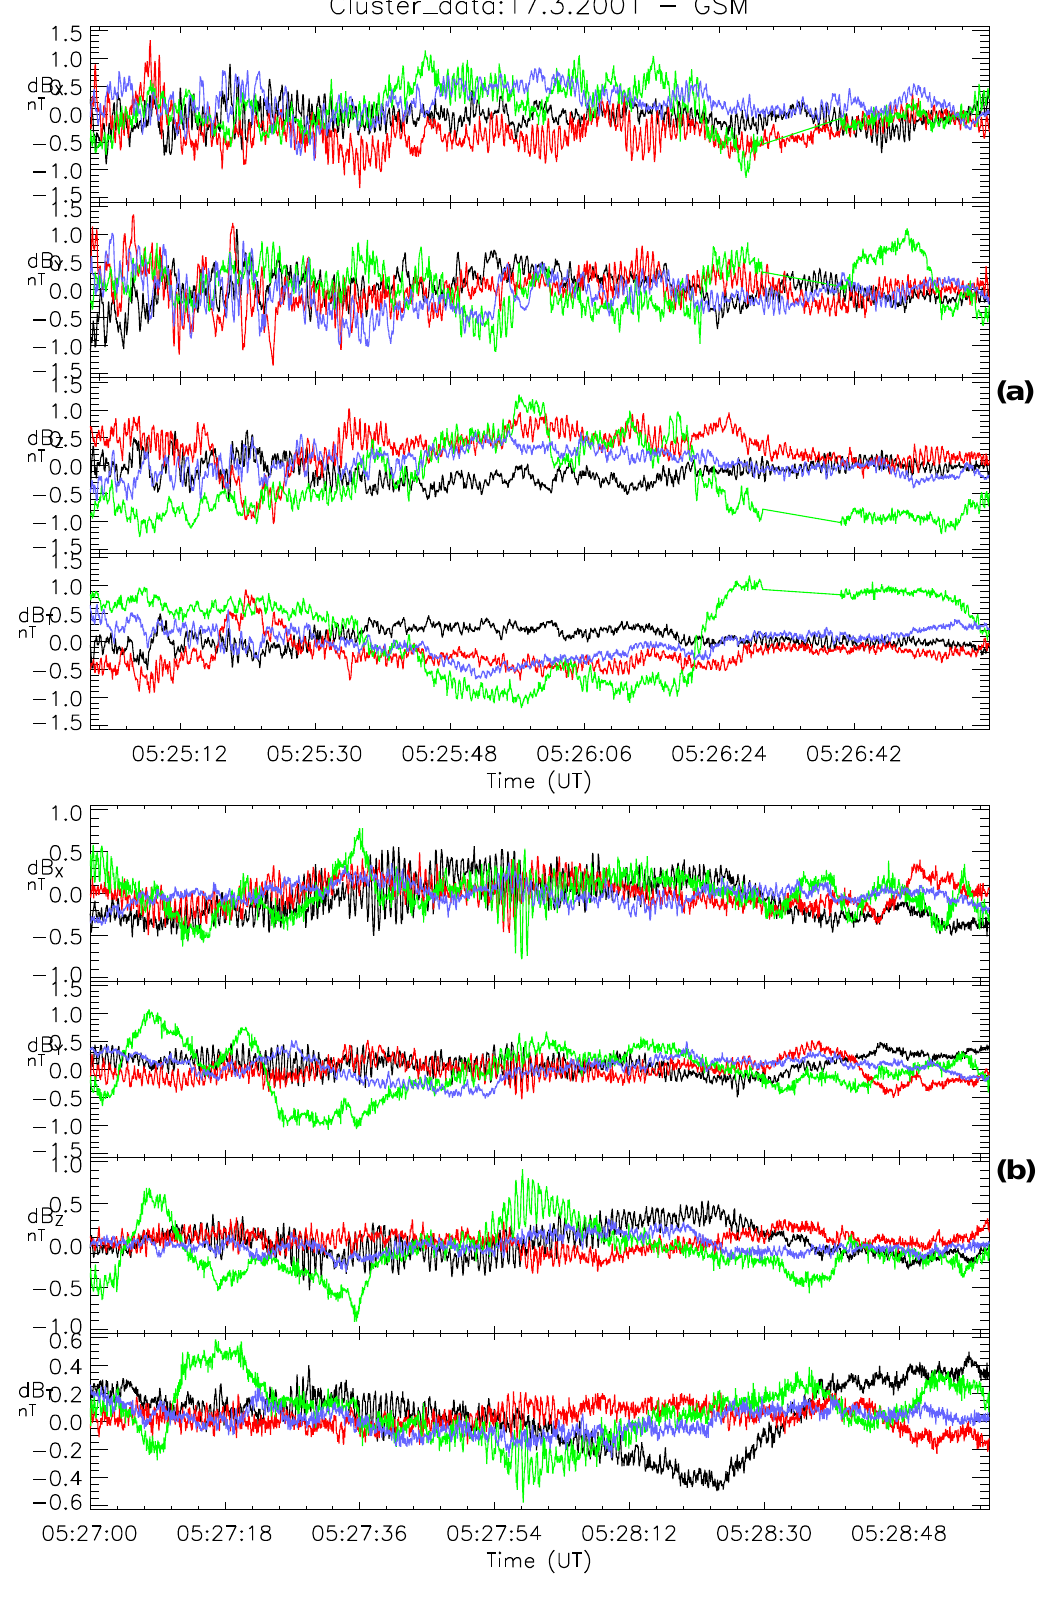
Fig. 9. De-trended magnetic field components between 05:25–05:27 (a) and between 05:27–05:29 (b)